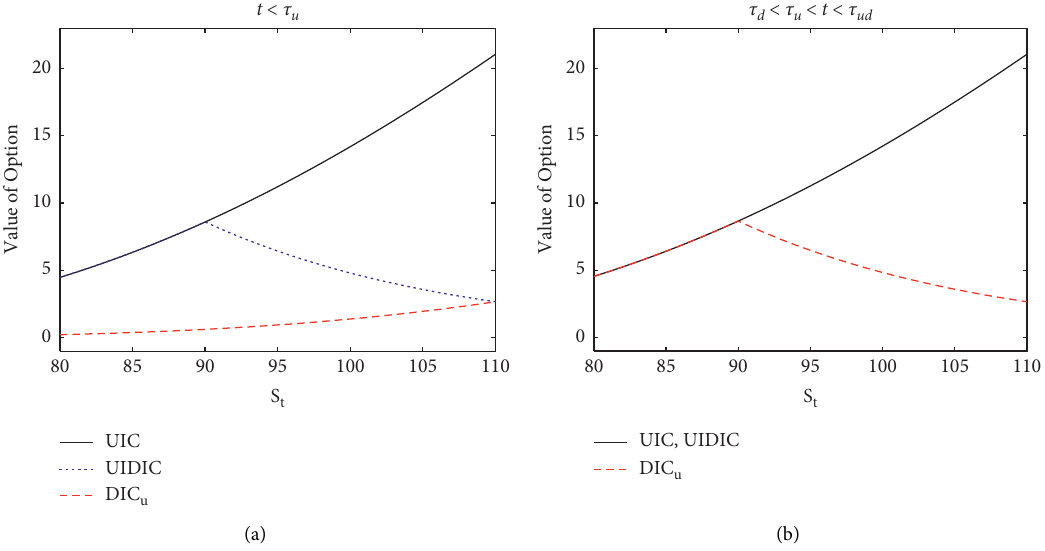
, UIDOC when (a) t < τ u